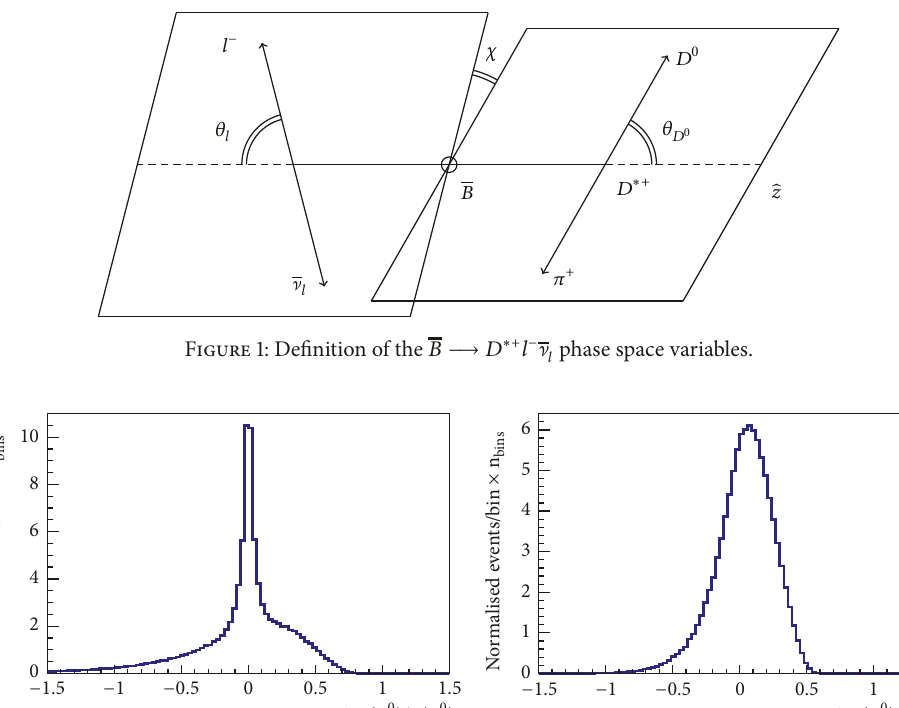
Figure 2: Relative resolution on the 𝐵 momentum magnitude for the 𝐵 󳨀→ 𝐷 ∗+ 𝜇 − ] 𝜇 decay, obtained using (left) full reconstruction and (right) equal velocity algorithms.